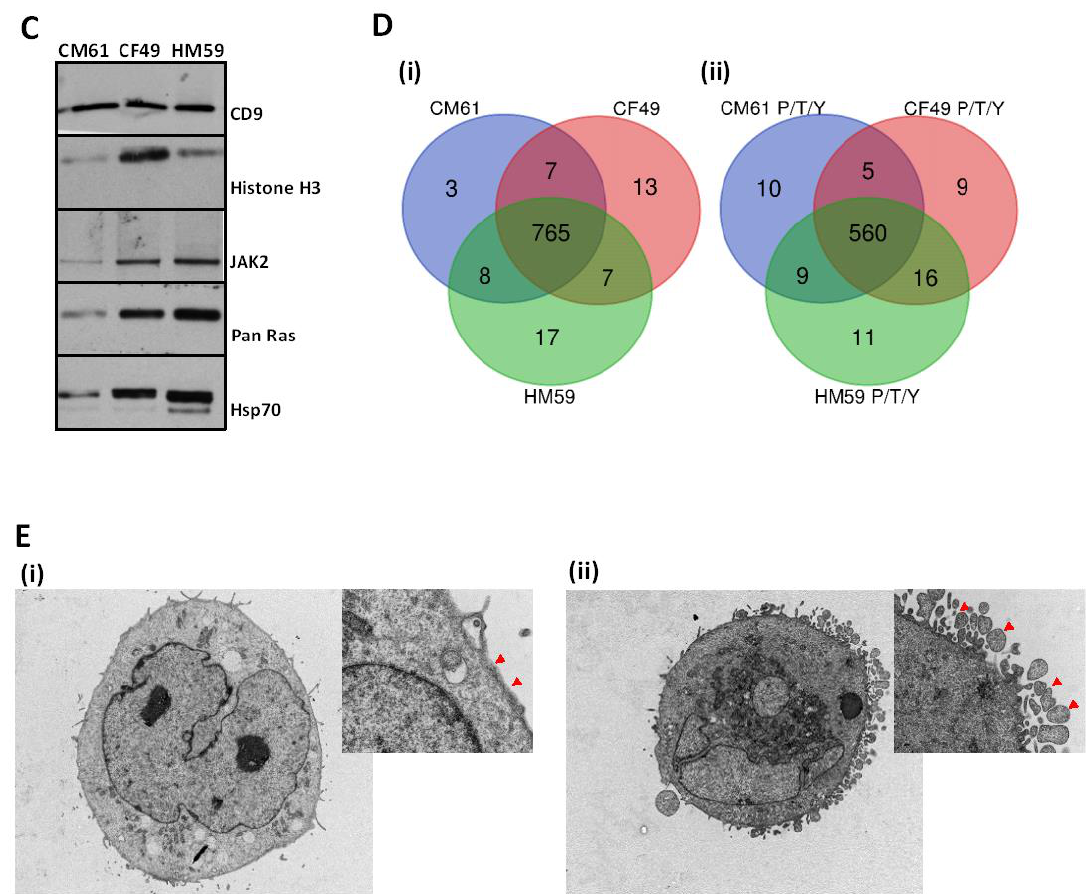
Figure 1. Characterization of extracellular vesicles secreted from patient derived CTC lines; ( A ): Representative images from transmission electron microscopy of concentrated EVs secreted from ( i ) CM61, ( ii ) CF49, and ( iii ) HM59 cell lines (Magnification ranges from 250,000 × to 300,000 × ); ( B ): NanoSight (Malvern Pananalytical Inc, MA, USA) analysis of size and concentration of EVs secreted from the CTC lines with size in nm on X axis versus scattering intensity on Y axis for ( i ) CM61 CTC cell line, ( ii ) CF49 Cell line, and ( iii ) HM59 cell line. ( C ): Western blot analysis illustrating the expression of characteristic EV markers CD9, HSP70 (System Biosciences, Palo Alto, USA) and Histone H3 (Cell Signaling Technology, Danvers, USA), and PDAC signaling markers such as JAK2 (Cell Signaling Technology, Danvers, USA) and Pan RAS (Cell Signaling Technology, Danvers, USA). Lane 1: Lysate of EVs from CM61; Lane 2: Lysate of EVs from CF49; Lane 3: Lysate of EVs from HM59; ( D ): Distribution of ( i ) proteins and ( ii ) phosphoproteins identified in the three PDAC patient derived CTC cell lines CM61, CF49, and HM59; ( E ): Knockdown of TSG101 ESCRT0 protein in CM61 cell line was done with shRNAs from the TRC consortium. Silencing of this essential ESCRT pathway protein does not allow pinching of EVs from the surface of membrane, allowing them to accumulate on the membrane surface: ( i ) TEM of cell surface of CM61 cell line transduced with scramble shRNA. Inset image is magnified image of the CM61 plasma membrane and the arrows indicate a smooth plasma membrane with no accumulation of budding bodies or vesicles. ( ii ) CM61 cell line transduced with shRNAs targeting TSG101 . Inset image shows a smooth plasma membrane being absent with accumulation of vesicular bodies and no secretion due to a defect in the secretion pathway. The arrows indicate the vesicles that are attached to the plasma membrane and are not released into the supernatant indicative of a defective secretion pathway.